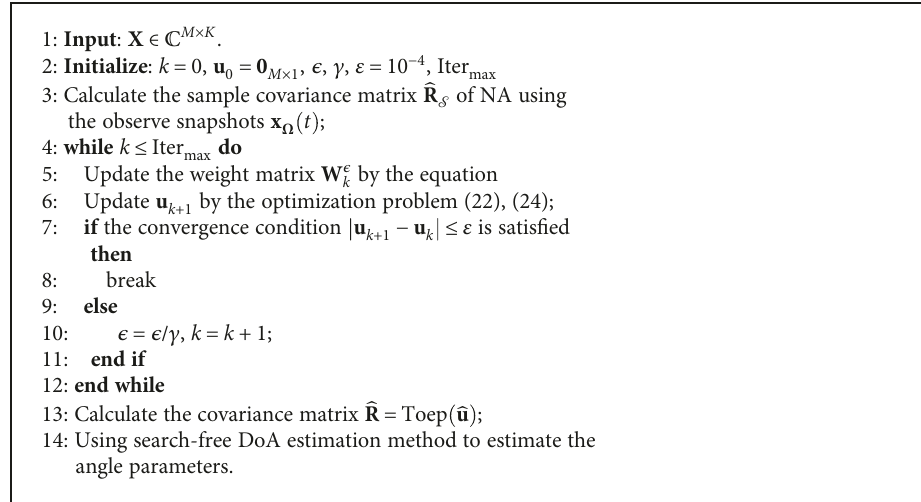
Algorithm 1: Gridless DoA estimation using iteratively reweighted covariance matrix reconstruction.